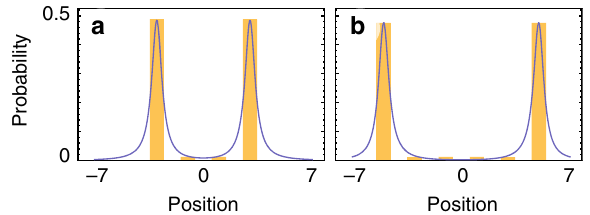
Fig. 5 Dirac kinematics and DCA. Numerical simulation of the explicit time- dependent solution of the one-dimensional Dirac equation (solid blue) and DCA (yellow bars) at ( a ) t = 3 and ( b ) t = 5 with a = 0.4 and θ 2 = π /20.